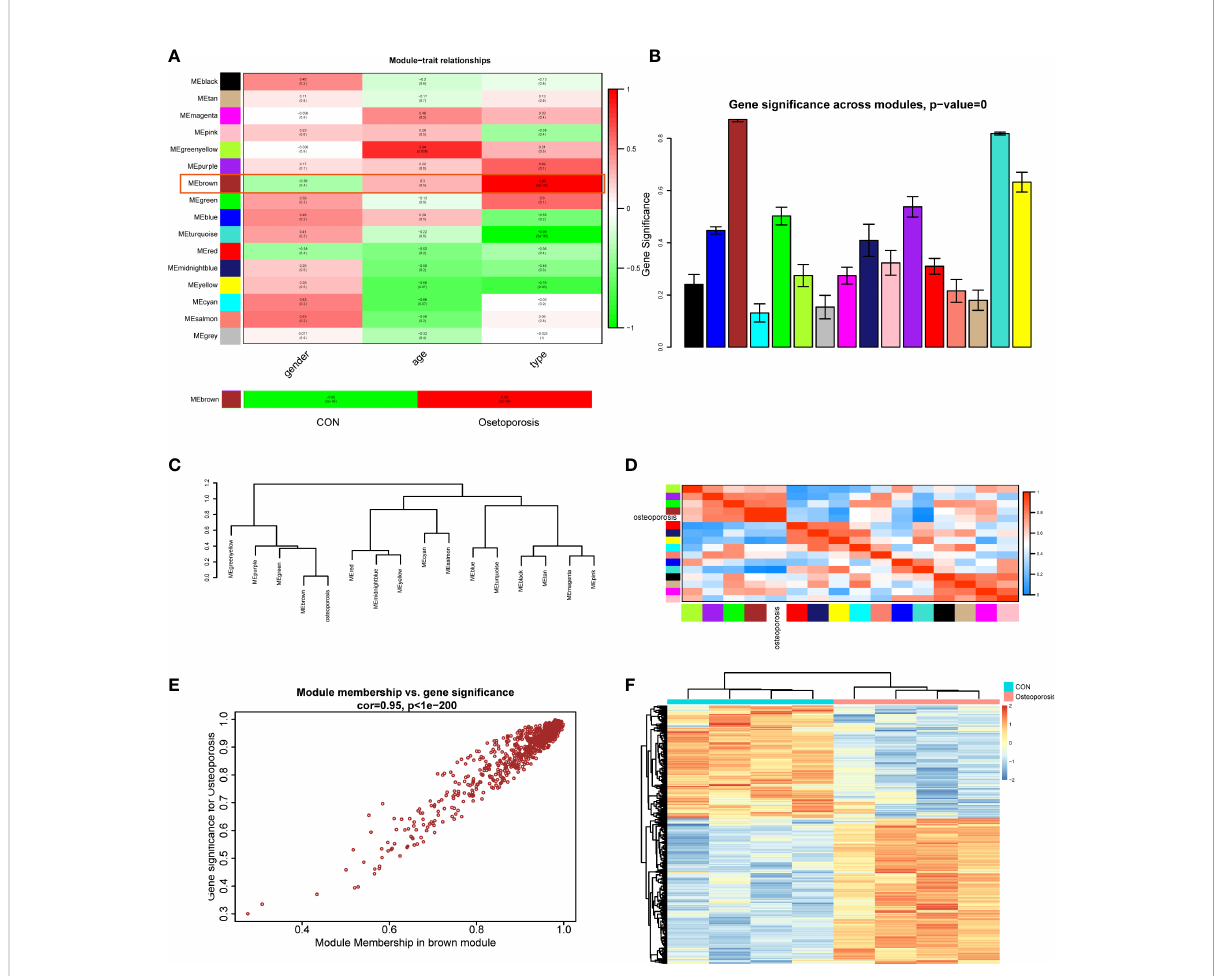
FIGURE 2 (A) Module – trait correlation heatmap between different clinical traits and modules. (B) Gene signi fi cance histogram of all clustered modules. (C) Cluster dendrogram of adjacencies in the eigengene network. (D) Heatmap of each eigenvalue in the eigengene network; blue indicated a negative correlation and red indicated a positive correlation. (E) Correlation scatter plot between module membership genes and gene signi fi cance in the brown module. (F) Expression heatmap of different groups in the brown